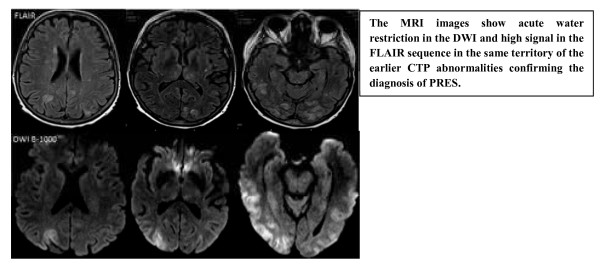
MRI images in PRES.